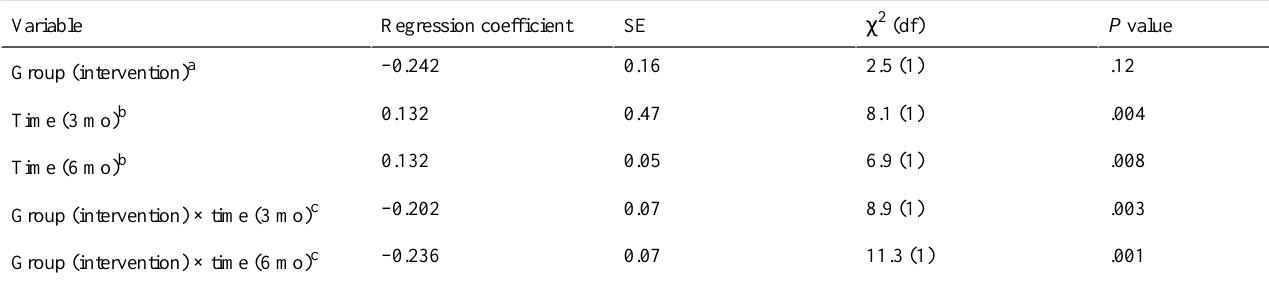
Table 3. Generalized estimating equation analysis of the effect of the intervention on overall defined daily dose.